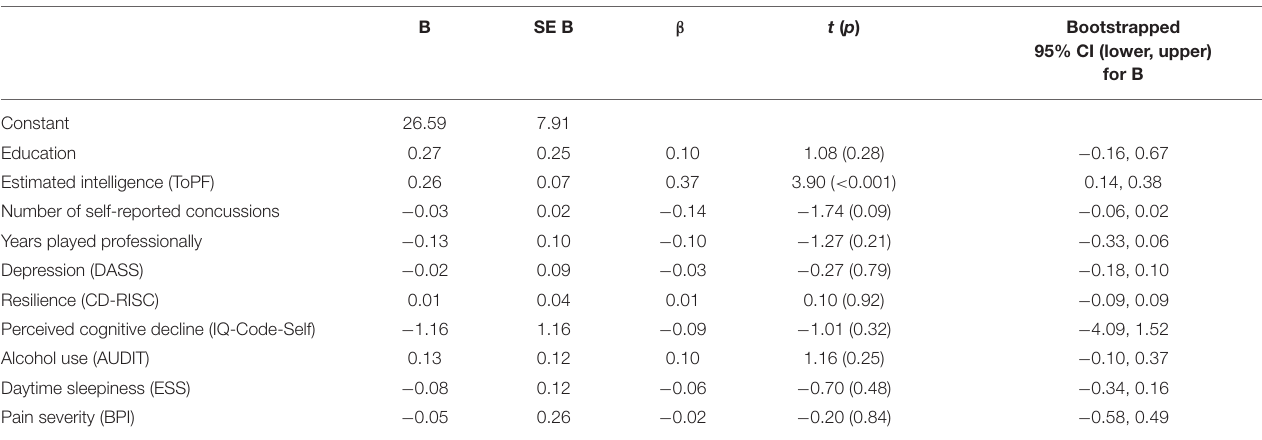
TABLE 7 | Simultaneous multiple regression model with the cognitive composite score as the